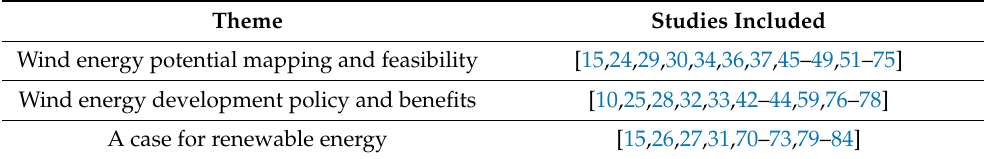
Figure 11. Themes and publications in each theme. Table 3. Theme-wise studies.